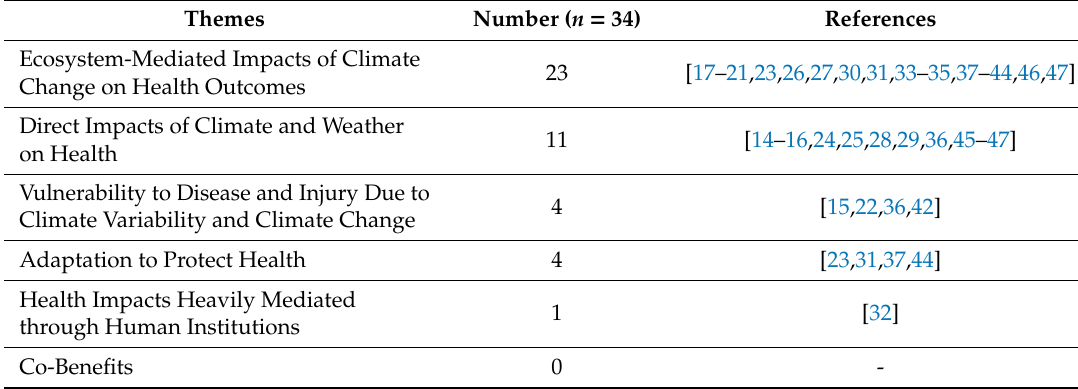
Table 5. Research themes of selected